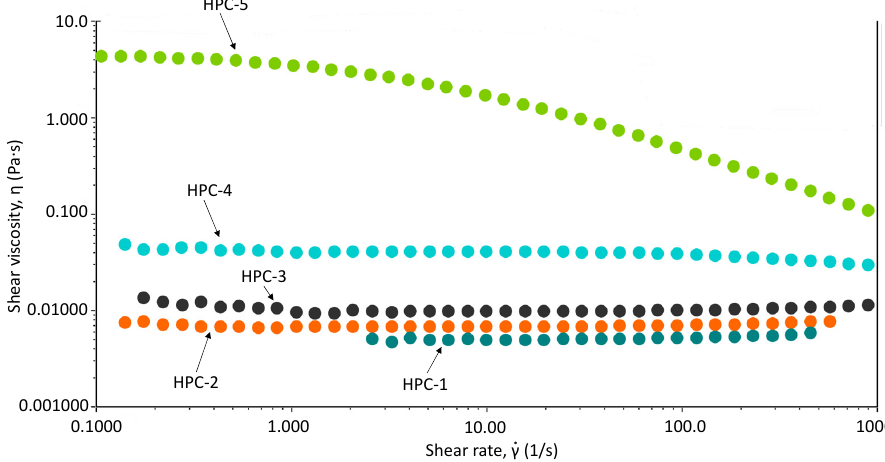
Figure 3. Shear viscosity plotted as a function of shear rate for variants of HPC. A comparison of the viscosity curves for several molecular weight grades of HPMC and MC is provided in Figure 4. Similar to the case of HEC and HPC, lower viscosities were found for lower molecular weight HPMC samples—HPMC-1 < HPMC-2 < HPMC-3 < HPMC-4 < HPMC-5—which ranged from 400,000 to 1,200,000 kDa. Similarly, higher molecular weight MC (MC-2) has a higher viscosity than lower molecular weight MC (MC-1). Figure 4. Shear viscosity plotted as a function of shear rate for variants of MC and HPMC.